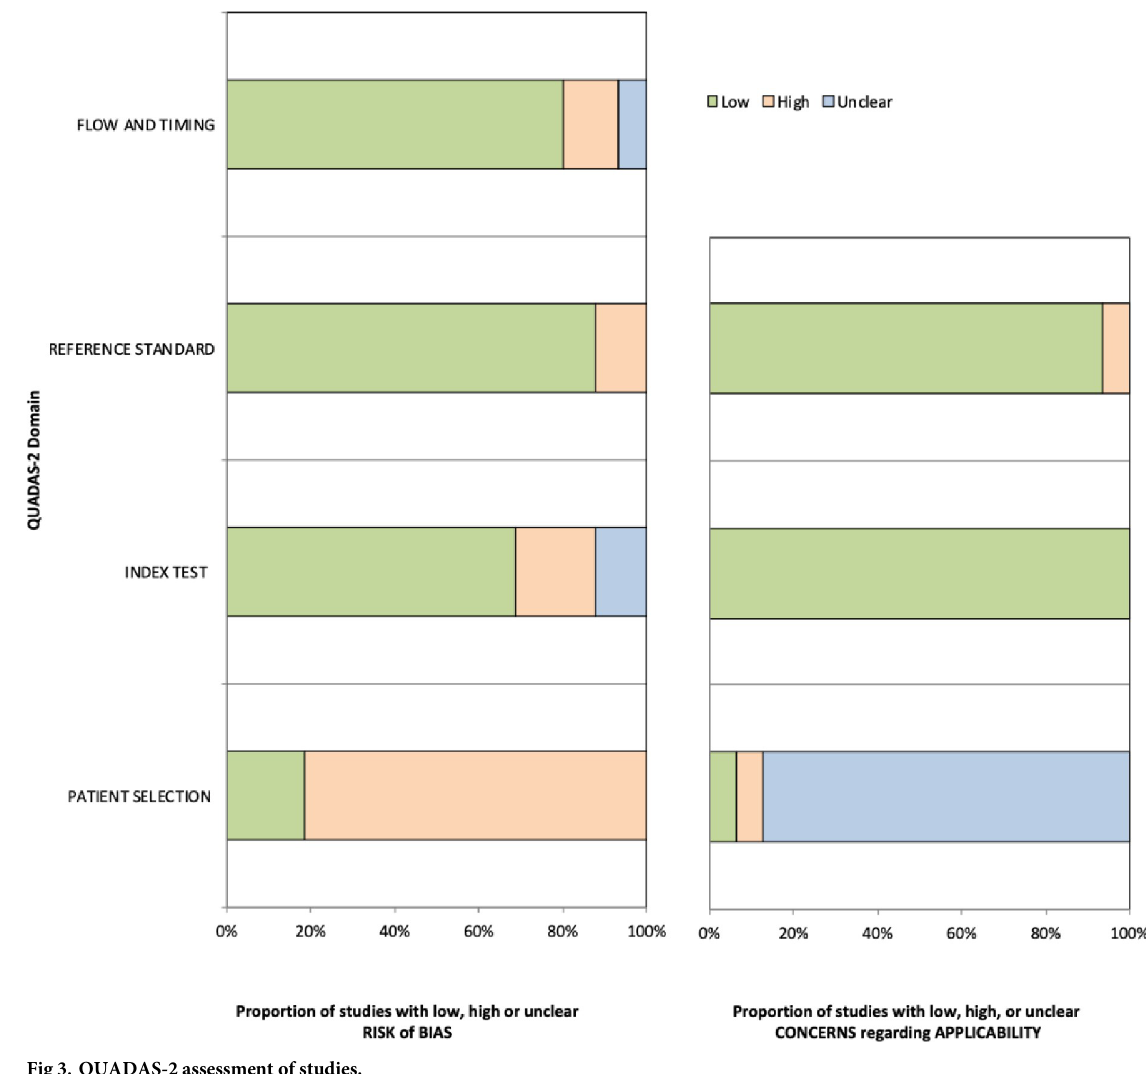
Fig 3. QUADAS-2 assessment of